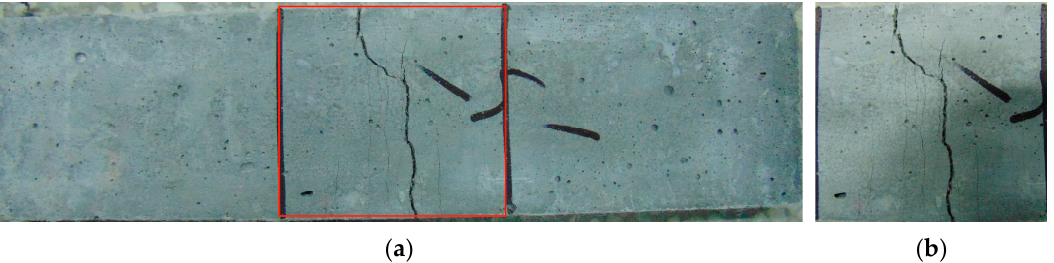
Figure 15. Multiple cracking pattern of flexural specimen for HDC. ( a ) Whole specimen. ( b ) Pure flexural zone.